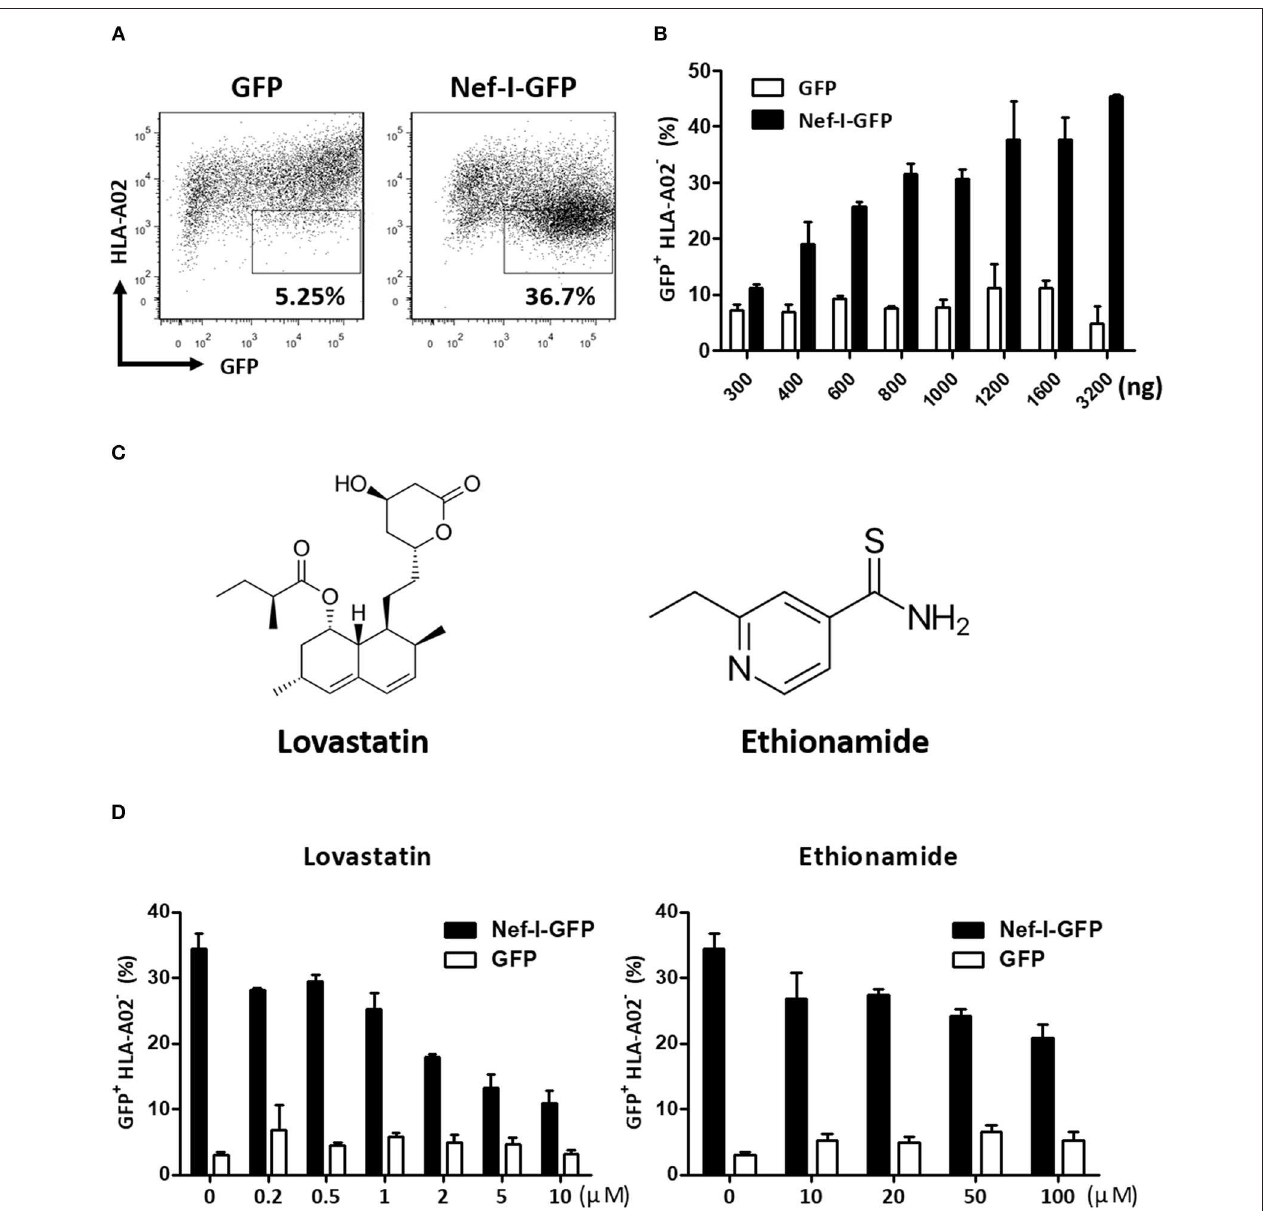
FIGURE 1 | Screen and identification of small molecular compounds inhibiting HIV-1 Nef-mediated MHC-I down-regulation. HEK293T cells were transfected with pcDNA3.1-Nef-IRES-GFP or pcDNA3.1-IRES-GFP (800 ng per well), At 48h post-transfection, Nef-mediated MHC-I down-regulation was analyzed by flow cytometry for staining of MHC-I (A) . The ratios of GFP + MHC-I − HEK293T cells after transfection of pcDNA3.1-Nef-IRES-GFP or pcDNA3.1-IRES-GFP at different concentrations were summarized with bar plot. Data show the means ± standard deviations in three independent experiments (B) . Structures of lovastatin and ethionamide (C) . Twelve hours after transfection of Nef-I-GFP or empty control plasmid, HEK293T cells were treated with lovastatin or ethionamide at different concentrations. Forty-eight hours after transfection, FACS analysis was performed for the percentages of GFP + MHC-I − cells. Data show the means ± standard deviations in three independent experiments (D)